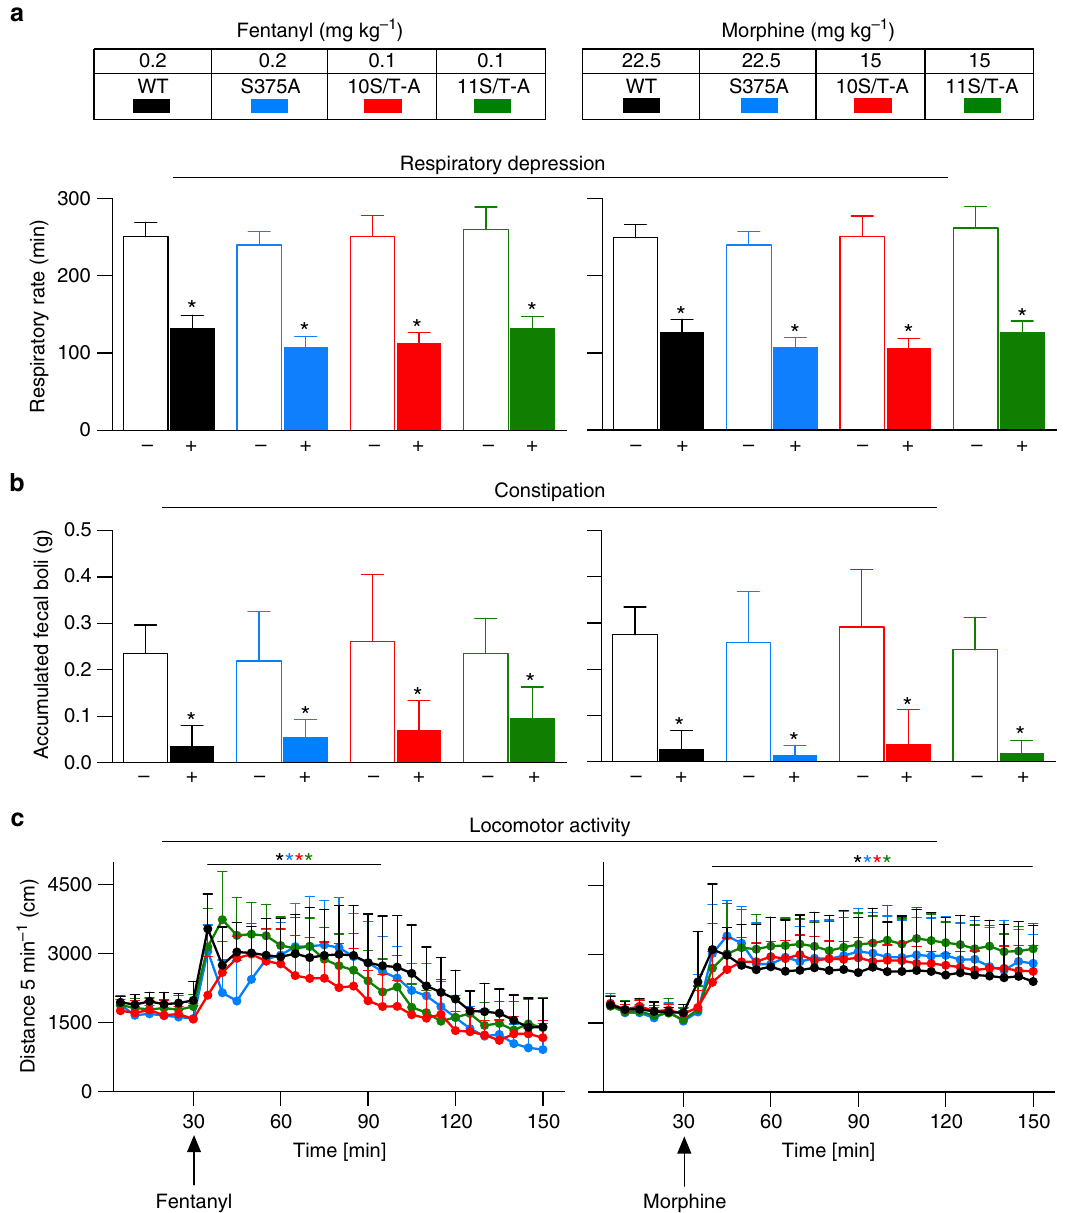
Fig. 3 Exacerbated side effects in phosphorylation-de fi cient MOP knock-in mice. Mice were treated with equally effective analgesia-producing doses of fentanyl (0.1 mg kg − 1 for 10S/T-A and 11S/T-A; 0.2 mg kg − 1 for WT and S375A) or morphine (15 mg kg − 1 for 10S/T-A and 11S/T-A; 22.5 mg kg −